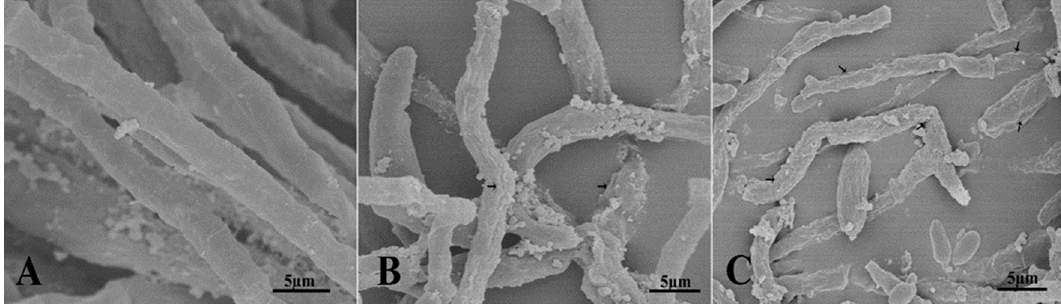
Figure 7. Ultrastructural changes induced by methanolic extracts of endophytic Bacillus strains HNH7 and HNH9; ( A ) = Control; ( B ) = HNH9 and ( C ) =